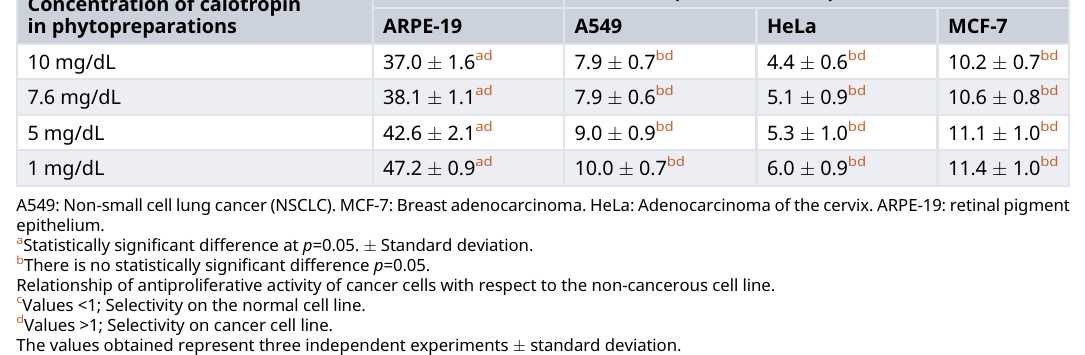
Concentration of calotropin in